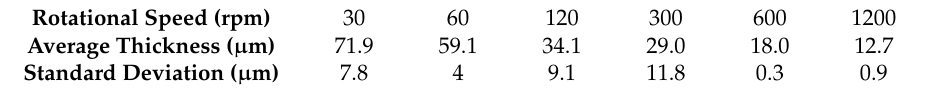
Table 1. Thickness of the PDMS membrane at position A and its corresponding rotational speeds.